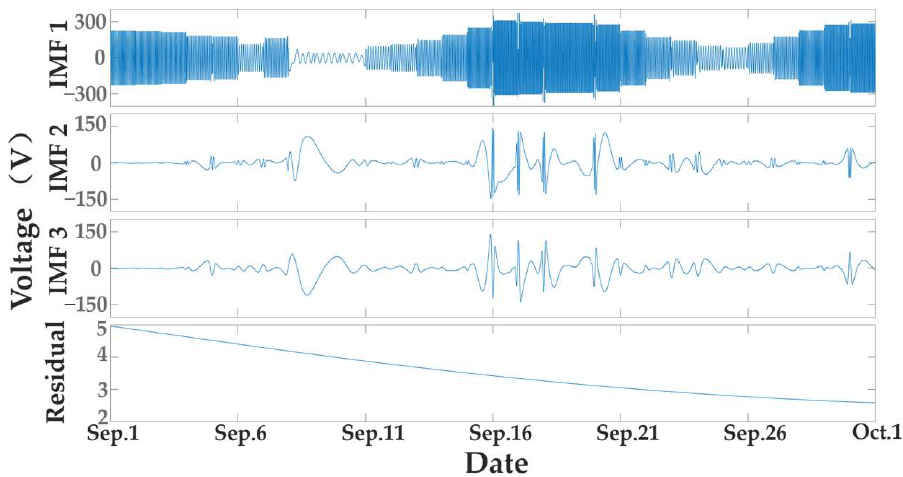
Figure 8. EMD decomposition of the monthly generation waveform of tidal power. The Hilbert spectrum of the monthly generation waveform of tidal energy is shown in Figure